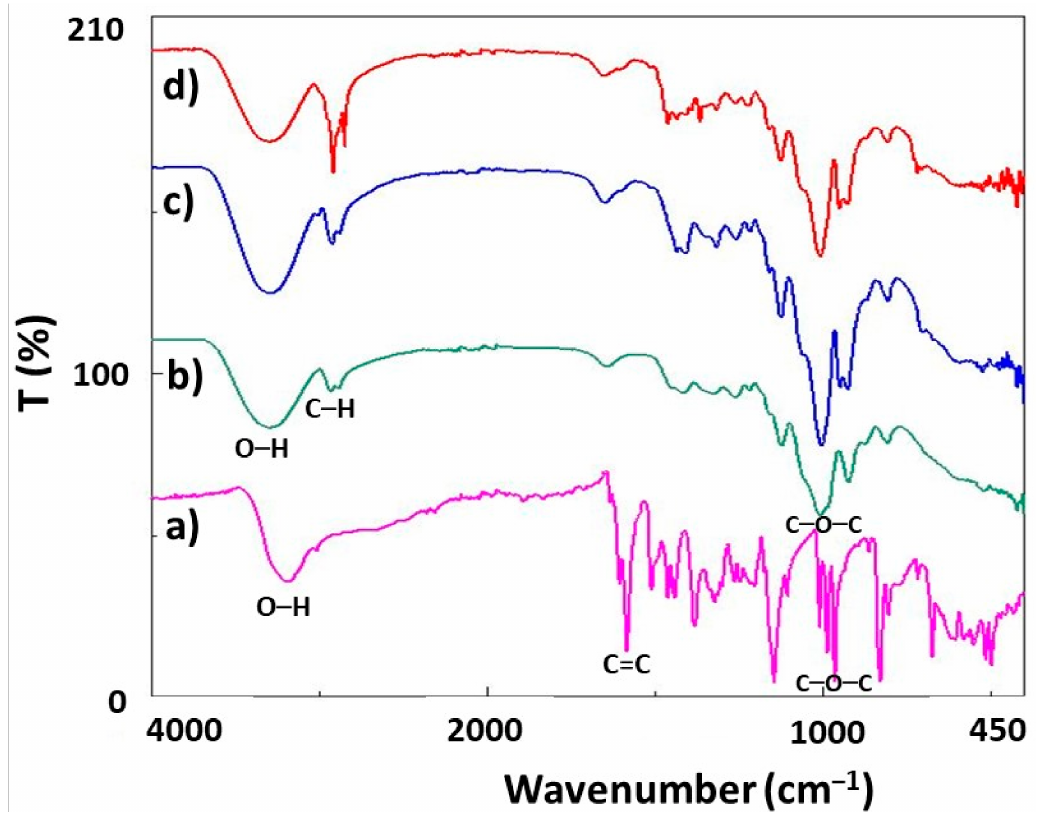
Figure 3. FTIR spectrums of the ( a ) RS, ( b ) hHL, ( c ) hHL/0.05RS, ( d ) hHL/0.1RS